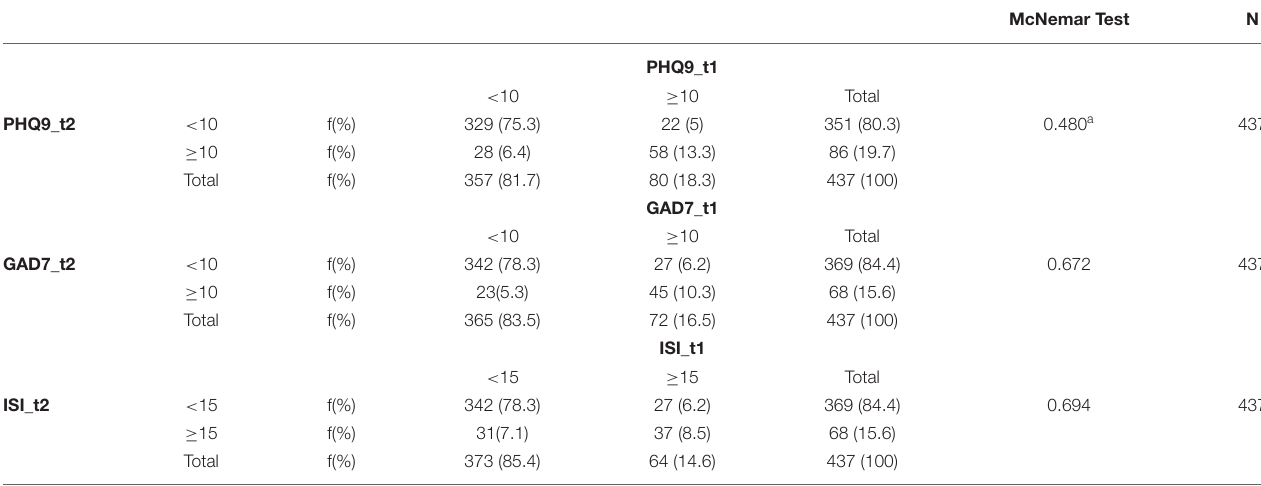
TABLE 4 | Number of participants exceeding the cut-off score for moderate depression/anxiety/insomnia measured during the lockdown (t1) and 6 months after the initiation of the lockdown